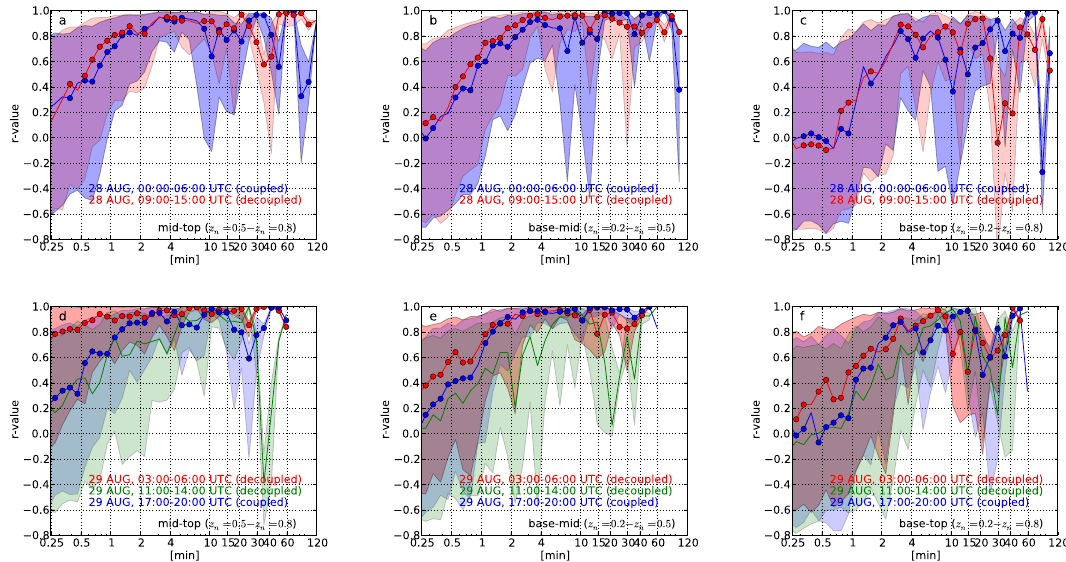
Fig. 10. Median (lines) and interquartile range (shaded) of correlation coefficients ( r values) for w between cloud middle-to-top levels (left), cloud middle-to-base levels (middle) and cloud base-to-top levels (right) as a function of wavelet temporal frequencies calculated using Eq. (4). (a–c) are for sub-sampled periods during 28 August: 00:00–06:00UTC (blue) and 09:00–15:00UTC (red). (d–f) are for sub- sampled periods on 29 August: 03:00–06:00UTC (red), 11:00–14:00UTC (green) and 17:00–20:00 UTC (blue); text in each panel indicates the sub-sampled time range and surface–cloud coupling state. Filled circles indicate median r values at the respective frequency that are statistically significantly different between the sub-sampled time periods at the 98% confidence level using a double-sided Wilcox rank-sum statistical test.